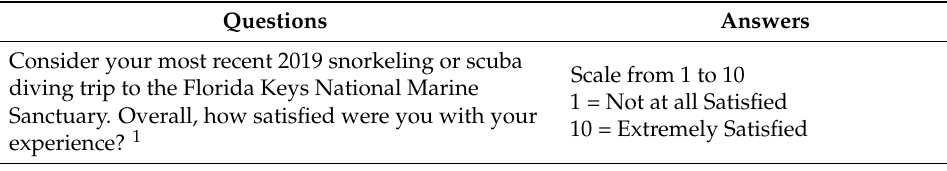
Table 1. Questions selected from a survey instrument for use in analysis in this study are shown with a response